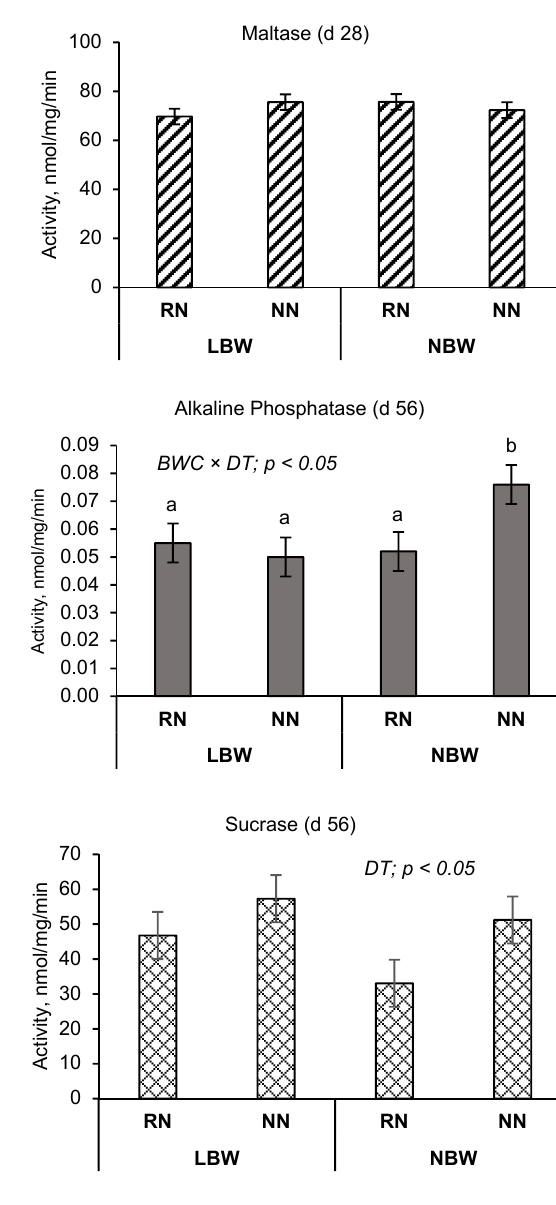
Figure 1. Enzyme activity in jejunal tissue for piglets d 28 and d 56 post-weaning. LBW; Low birth weight, NBW; normal birth weight, RN; restricted nutrition; NN; normal nutrition, BWC; birth weight category, DT; dietary treatment. a, b Lowercase superscripts are indicative of a significant interaction. There was a significant main effect of dietary treatment (NN vs. RN) on sucrase activity 54.3 vs. 39.9 ( p < 0.05).